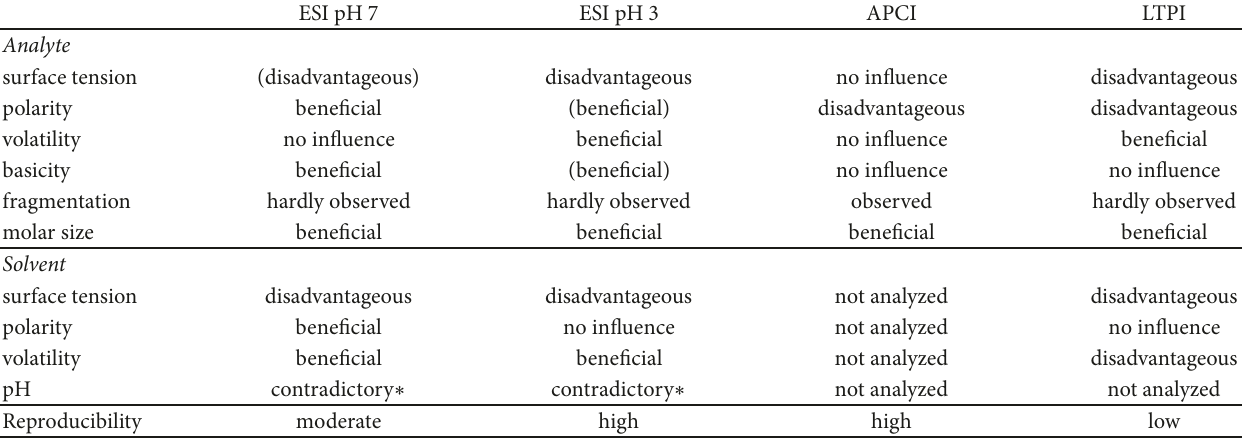
Table 1: Summary of analyte and solvent characteristics in how they impact sampling efficiency of the three ionization methods, ESI, APCI, and LTPI, for